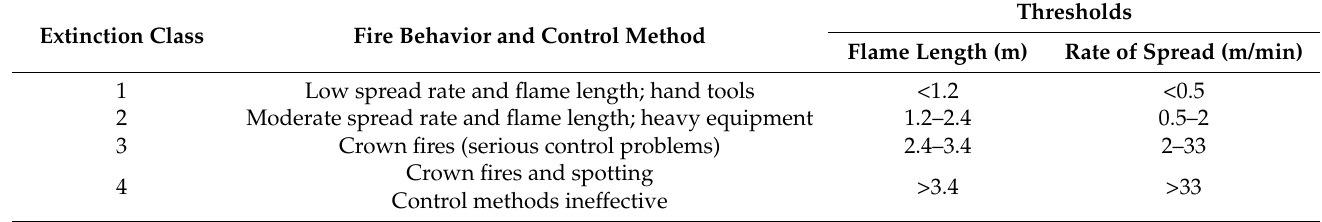
Table 4. Extinction classes and thresholds for flame length and rate of spread (based on [111,112]).